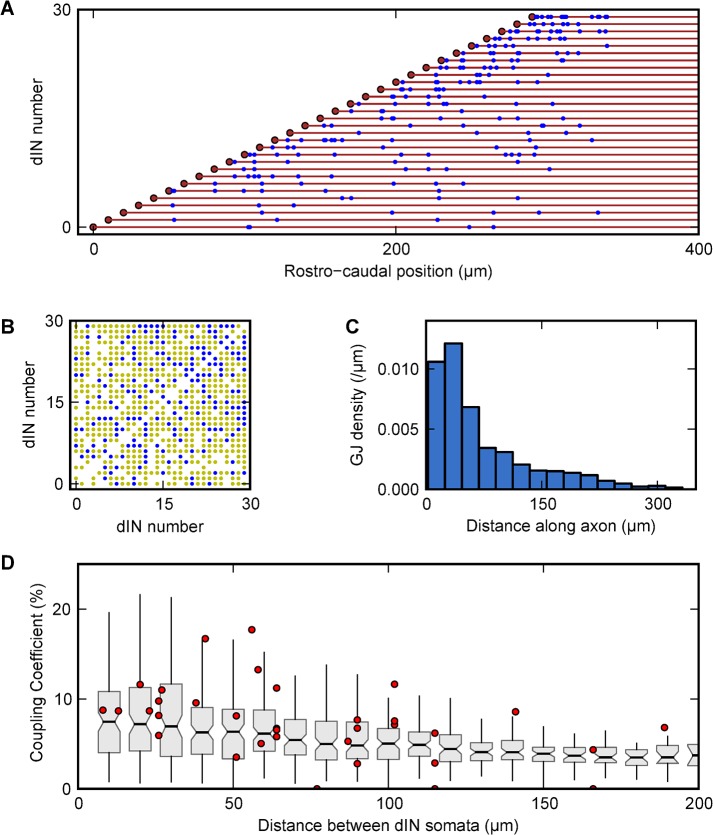
Gap junction distribution and coupling coefficients between dINs.(A) The chosen layout of gap junctions in the column of 30 dINs (somata red circles spaced 10 μm apart) with descending axons (red lines). Blue dots represent one side of a gap junction (hemichannel), which connects to another gap junction at the same position along the column (x axis). (B) Direct and indirect dIN to dIN coupling: directly coupled neurons (blue dots); indirectly coupled via the axon of another neuron (yellow dots); coupled via more than 3 axons (empty square). (C) Histogram of gap junction distributions along the axons of dINs. In order to get good coupling between dINs, we found that gap junctions needed to form close to the somata. (D) Comparison of the coupling coefficients between pairs of dINs measured experimentally (red circles; [29]) and in the model (as in Fig 3).